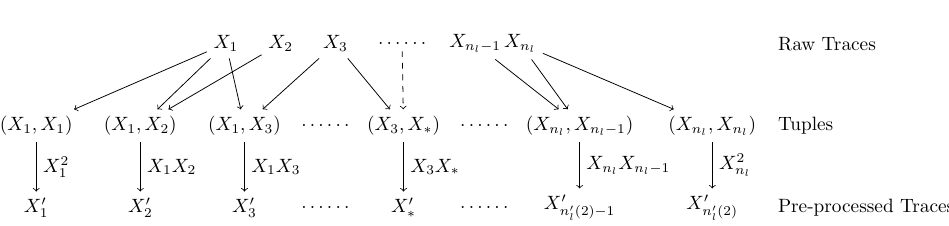
Figure 2: Exemplary multiplicative pre-processing of X for order d =